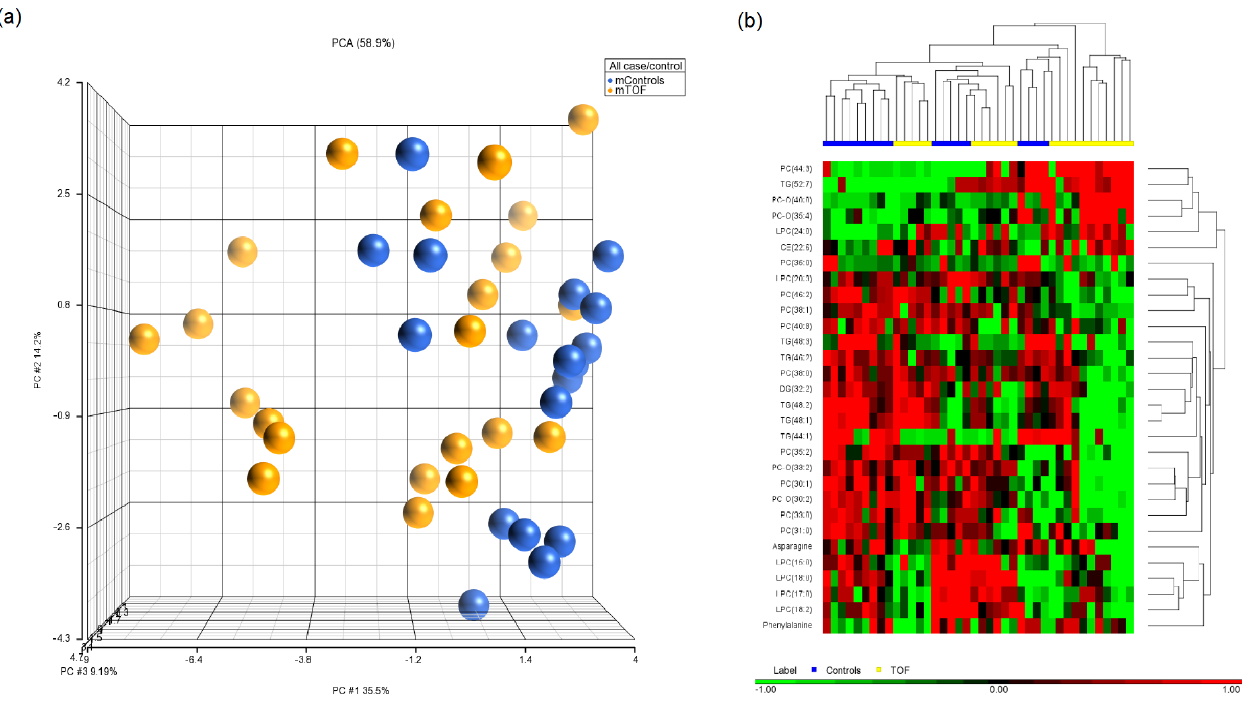
Figure 3. Visualization of the significant metabolites ( p < 0.05) in ( a ) principle component analysis and ( b ) hierarchical clustering distinguishing between mControls vs. mToF.